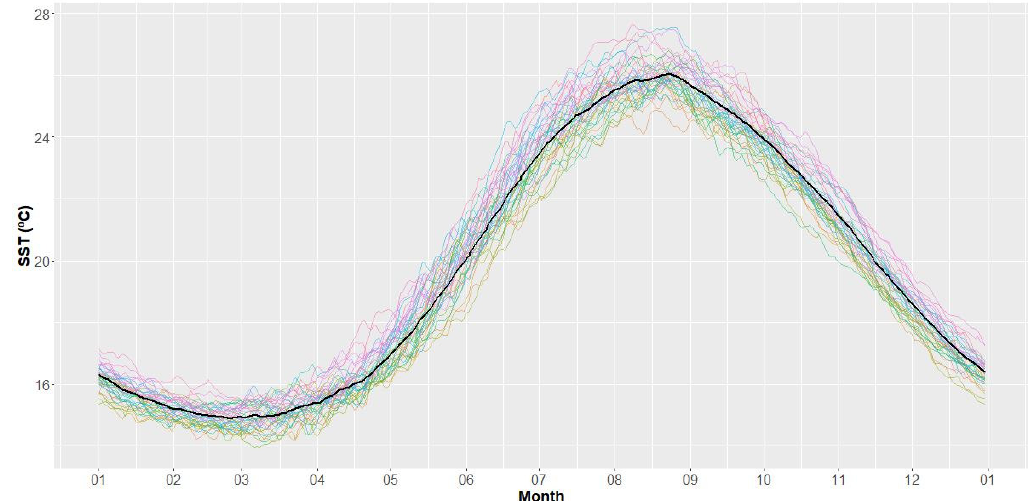
Figure 1. Annual cycle for the mean Mediterranean SST from 1982 to 2019. Each line represents a year in the study period, and the black solid line indicates the climatic mean.